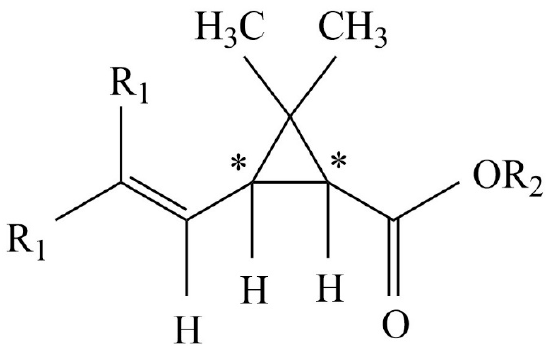
Figure 1. The general structure of the tested pyrethroic acids. The chiral carbon atoms are indicated with * symbols. The R 1 can be methyl (chrysanthemic acid), chlorine (permethrinic acid), or bromine (deltamethrinic acid). The R 2 can be hydrogen (free acid) or alkyl substituent (ester).